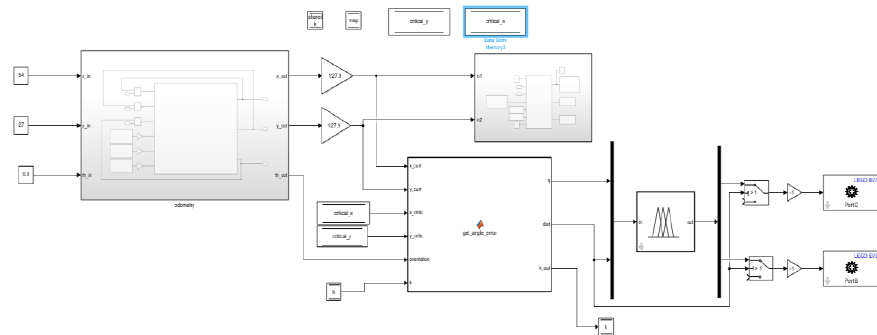
Fig. 7. The whole motion planning